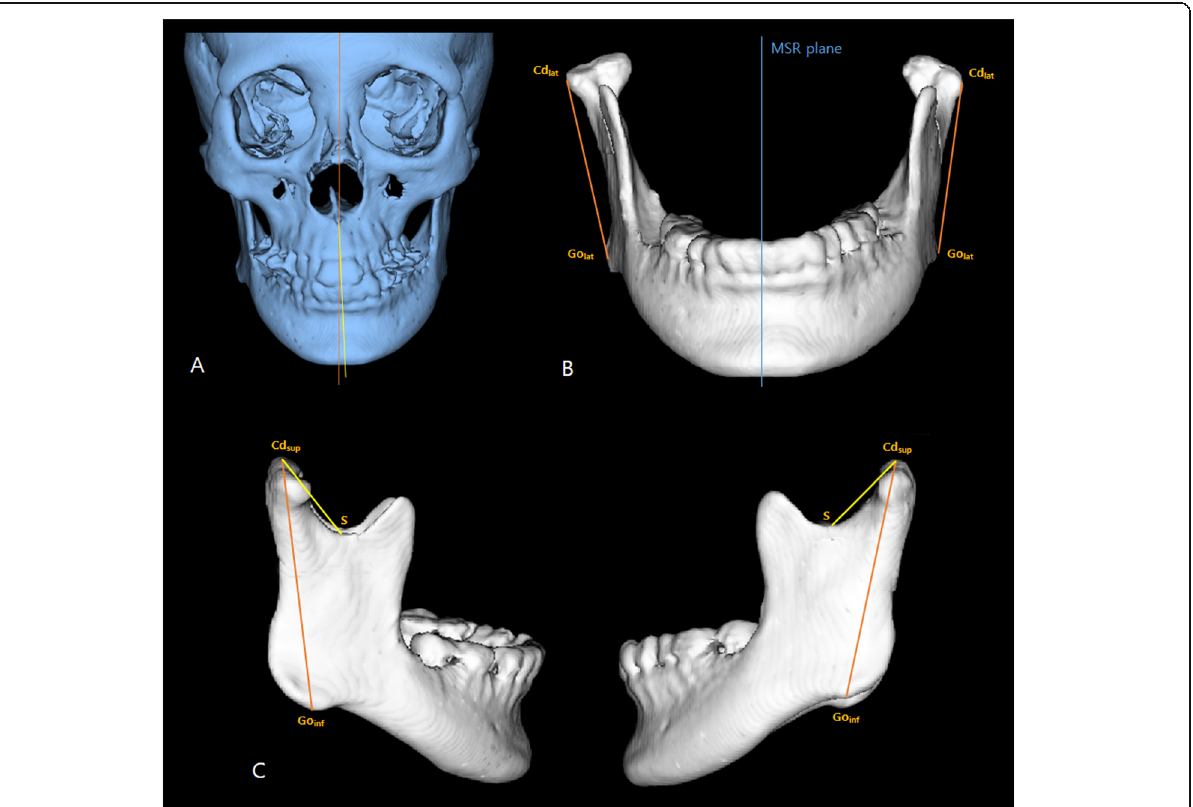
Fig. 4 A subject consistent with the results of this present study. a Menton is deviated to the left side. b The frontal ramal inclination is greater in the right side (non-deviated side) than the left side (deviated side). c The ramus length and neck length are greater in the right side (non- deviated side) than the left side (deviated